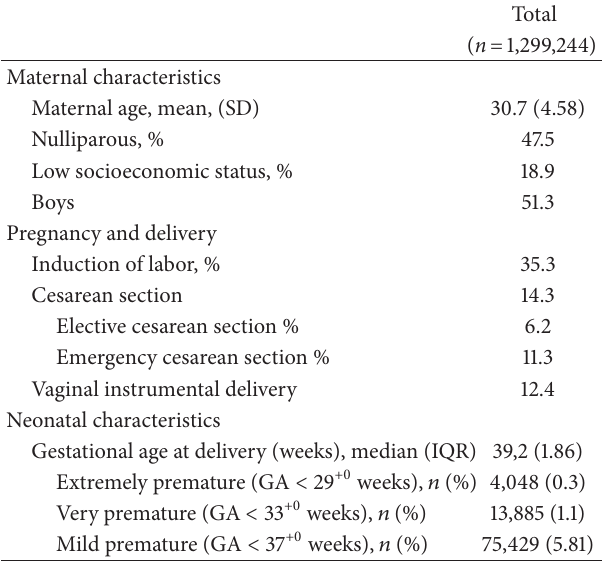
Table 1: Characteristics of the 1,299,244 pregnancies in the Nether- lands,